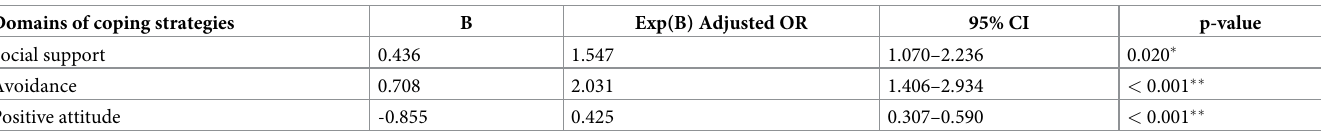
Table 5. Coping strategies associated with perceived stress